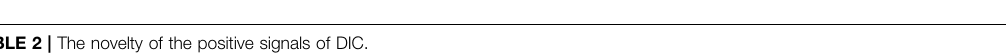
TABLE 2 | The novelty of the positive signals of DIC. Suspected